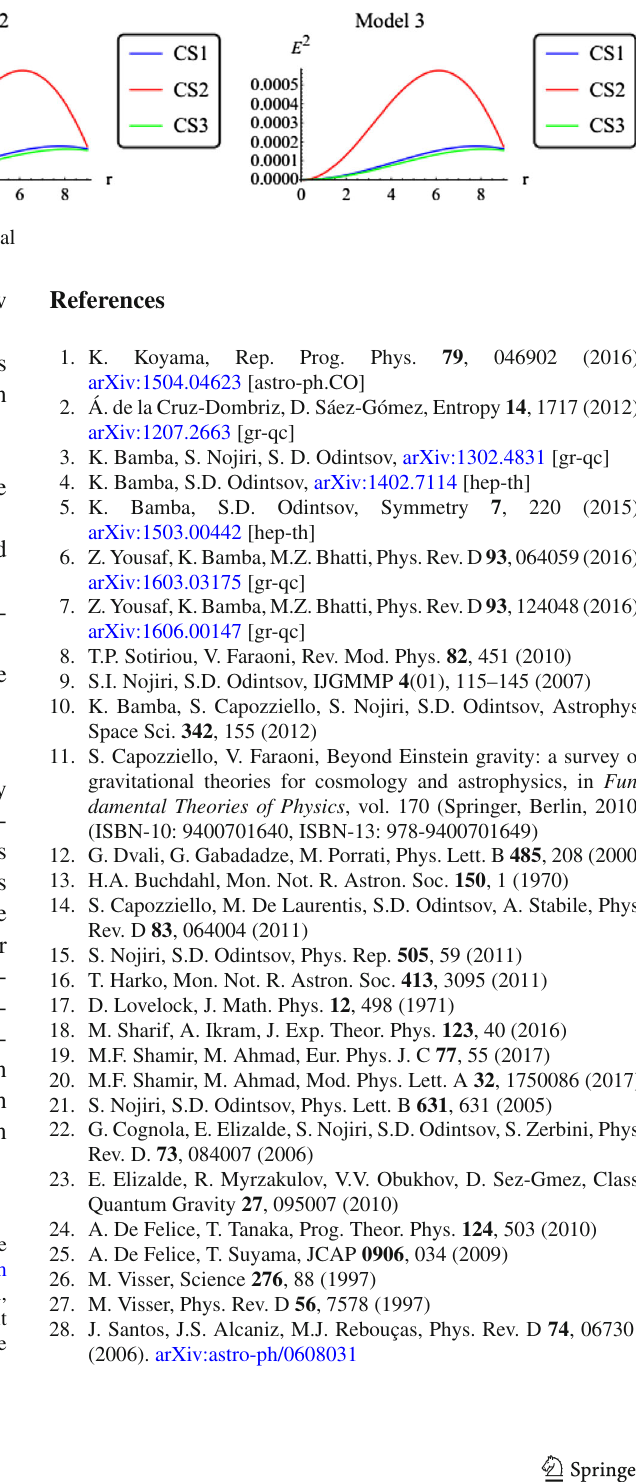
Fig. 20 Variations of surface charge density σ with respect to the radial